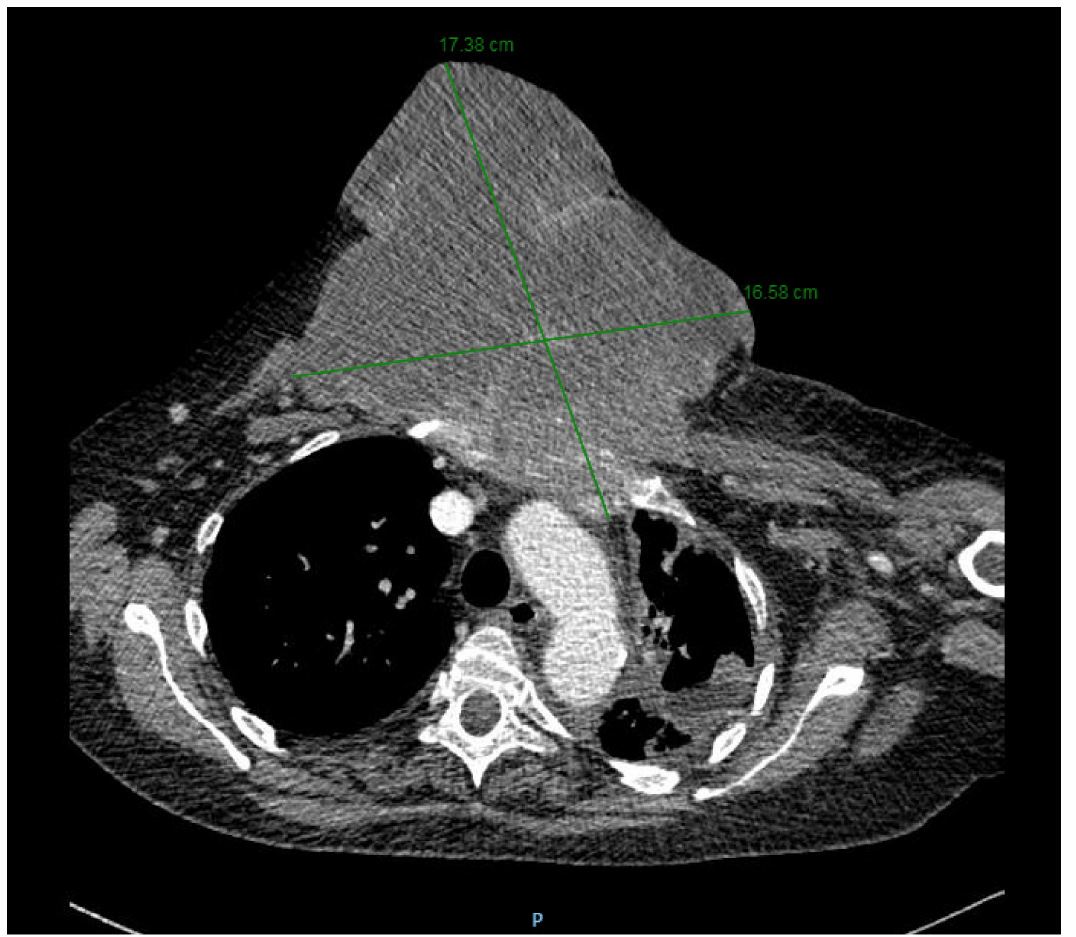
Figure 7. Preoperative CT scan (transversal